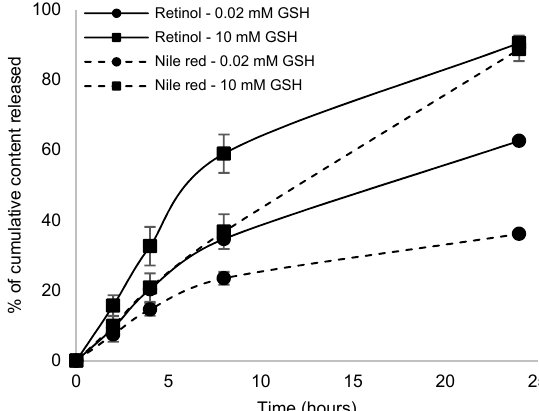
Figure 9. In vitro release of Nile red (dashes) and retinol (full line) from (PEG– block –PLA)-blend-(PLA) nanocarriers at 37 °C with glutathione (GSH basal level (0.02 mM) and GSH activation level (10 mM).